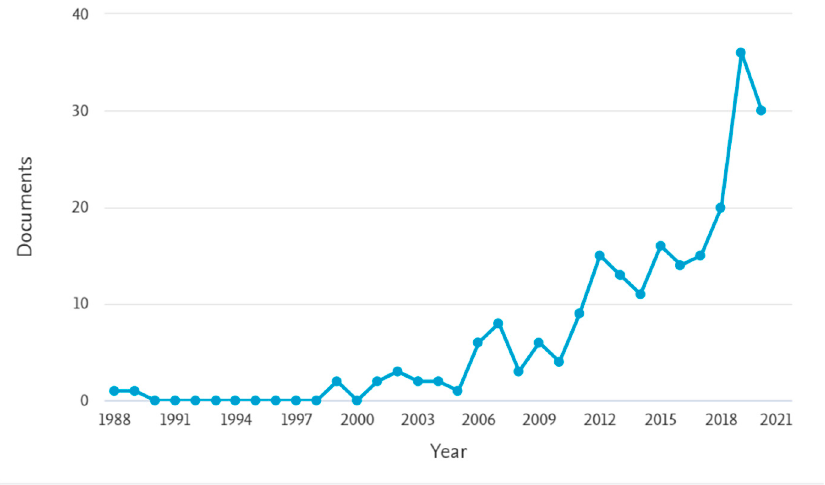
Figure 1. Annual scientific paper publication rate as indexed by Scopus records (doa 18/4/2021) for the keywords ‘tree AND fruit AND yield AND estimation’.